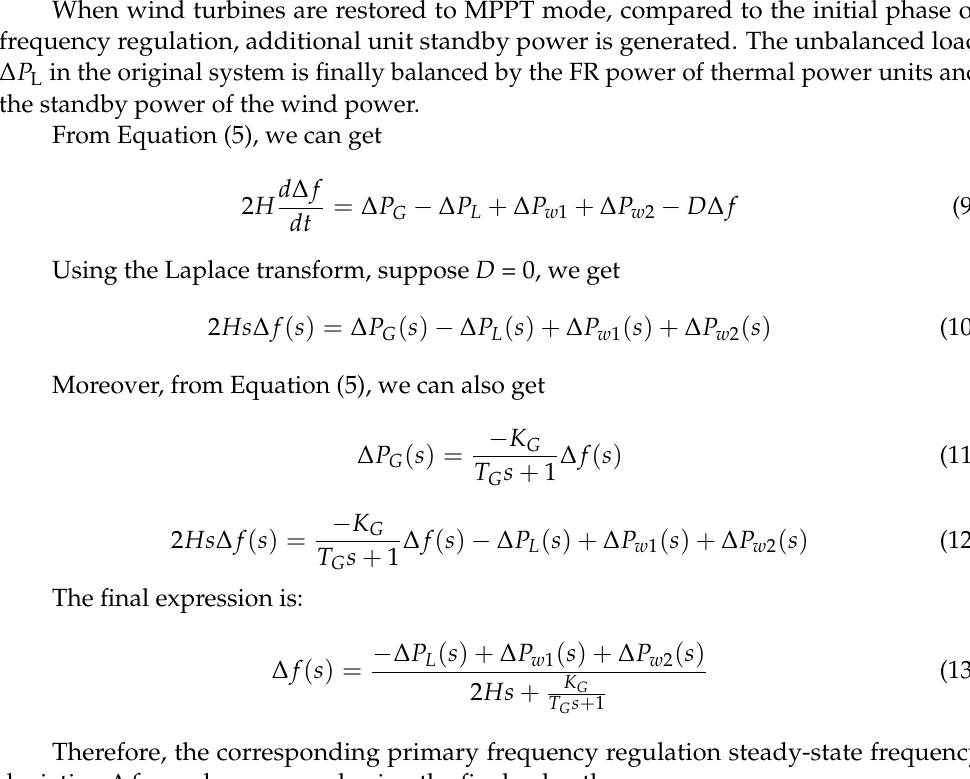
Figure 5. Variable pitch standby power.